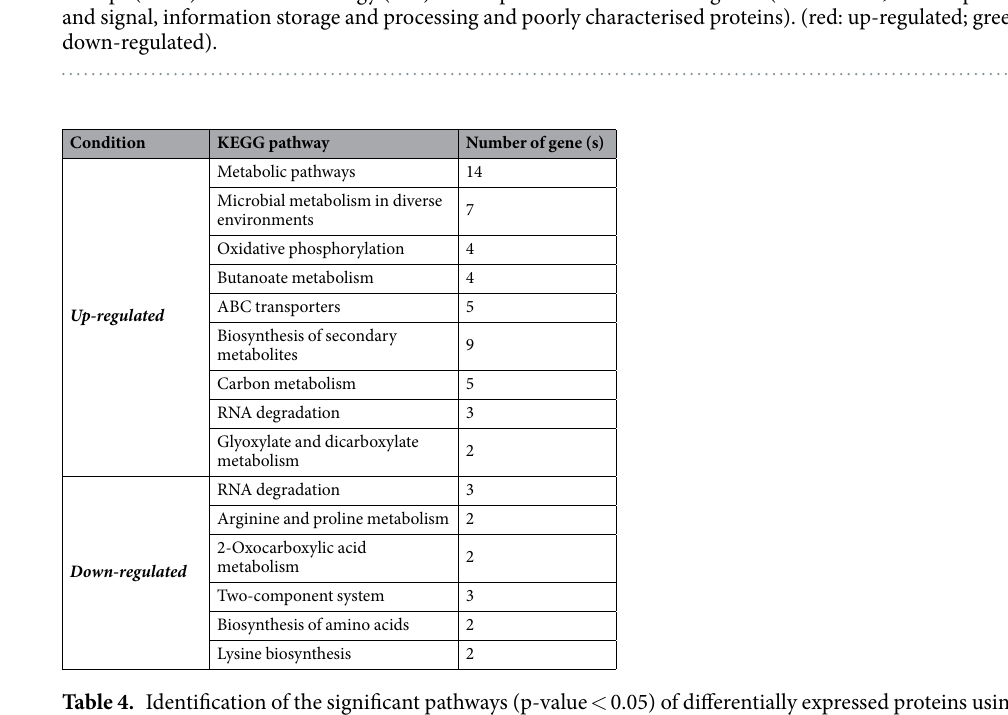
Table 4. Identification of the significant pathways (p-value < 0.05) of differentially expressed proteins using KEGG pathway